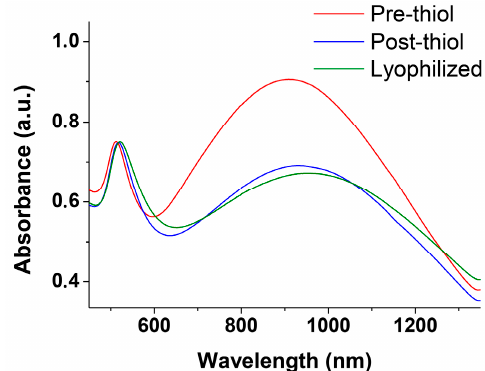
Figure 5. Vis–NIR spectra in the plasmon resonance region of nanowires before passivation with thiol 2 , immediately after the passivation with thiol 2 and after lyophilization and redissolution in water.